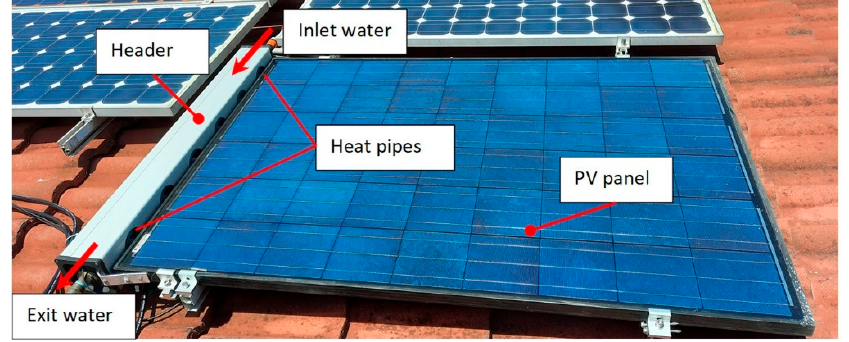
Figure 2. PVT panel mounted on the roof.